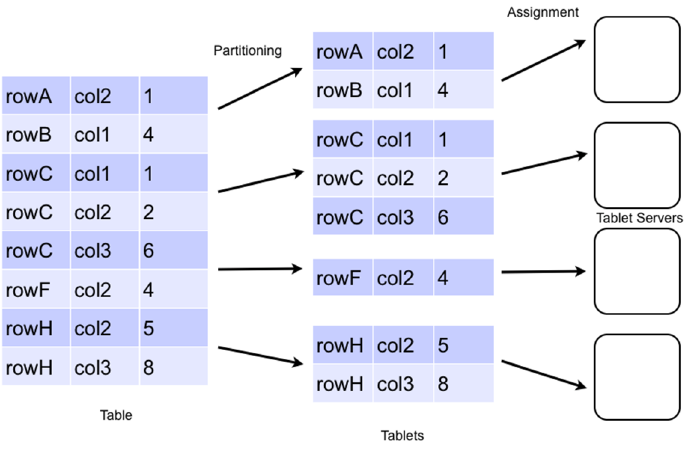
Figure 1. Data distribution of Apache Accumulo [16].